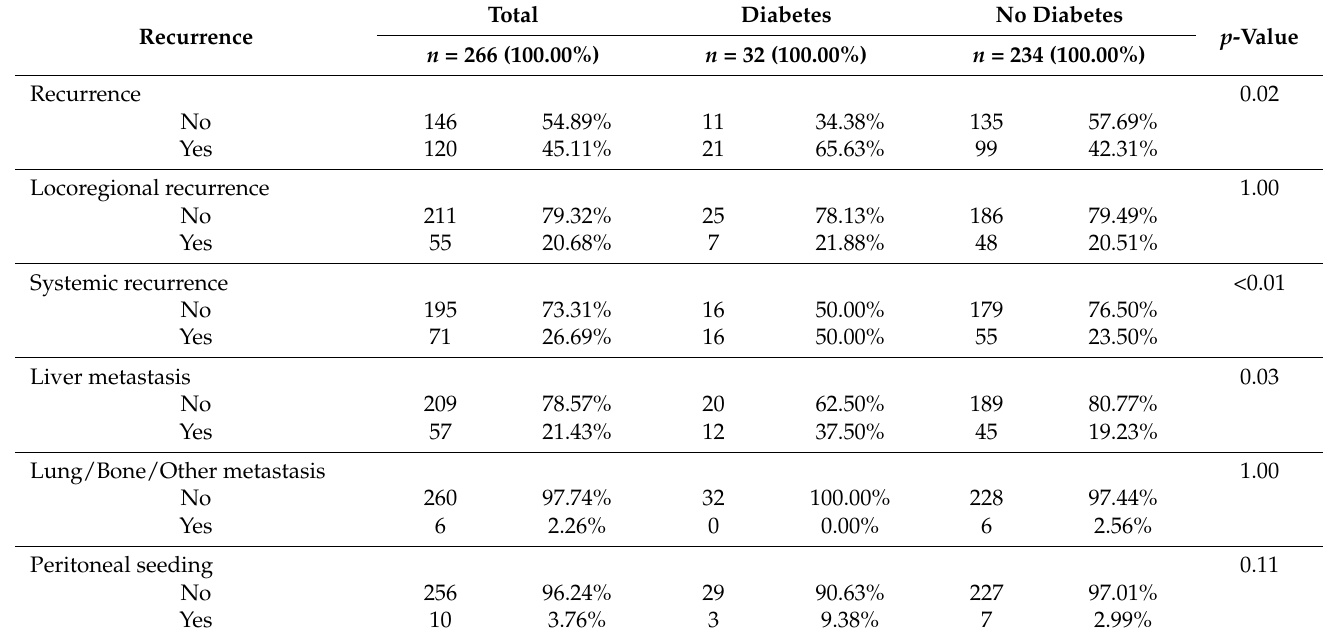
Table 3. Postoperative recurrence between diabetes group and no diabetes group in ampullary adenocarcinoma patients.